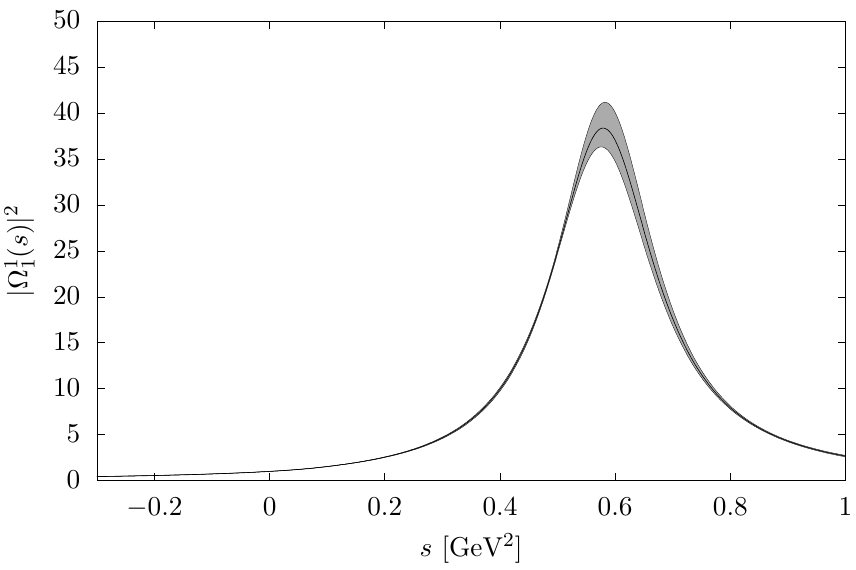
Figure 5. Squared absolute value of the Omn(cid:18)es function j (cid:10) 1 ( s ) j 2 , calculated with the elastic 1 P -wave (cid:25)(cid:25) scattering phase shift (cid:14) 1 . The uncertainty band is generated by varying all parameters 1 apart from the phase values at s 0 and s 1 , which are kept (cid:12)xed at their central values (3.1) from the Roy solution